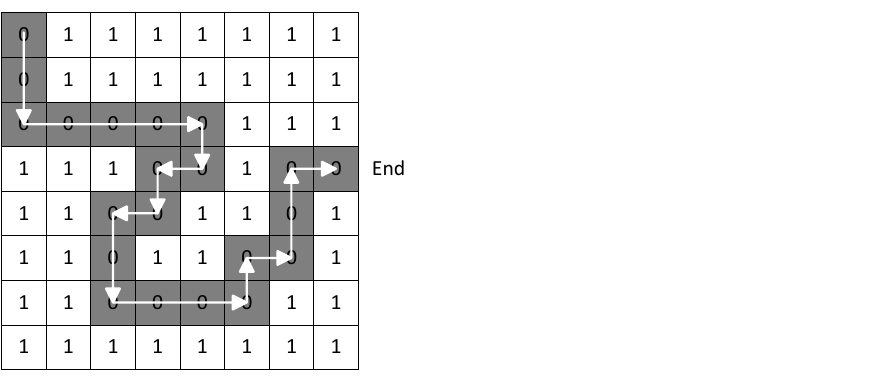
Figure 6. A randomly generated mask, where “0” represents mask area and “1” represents re- served data.